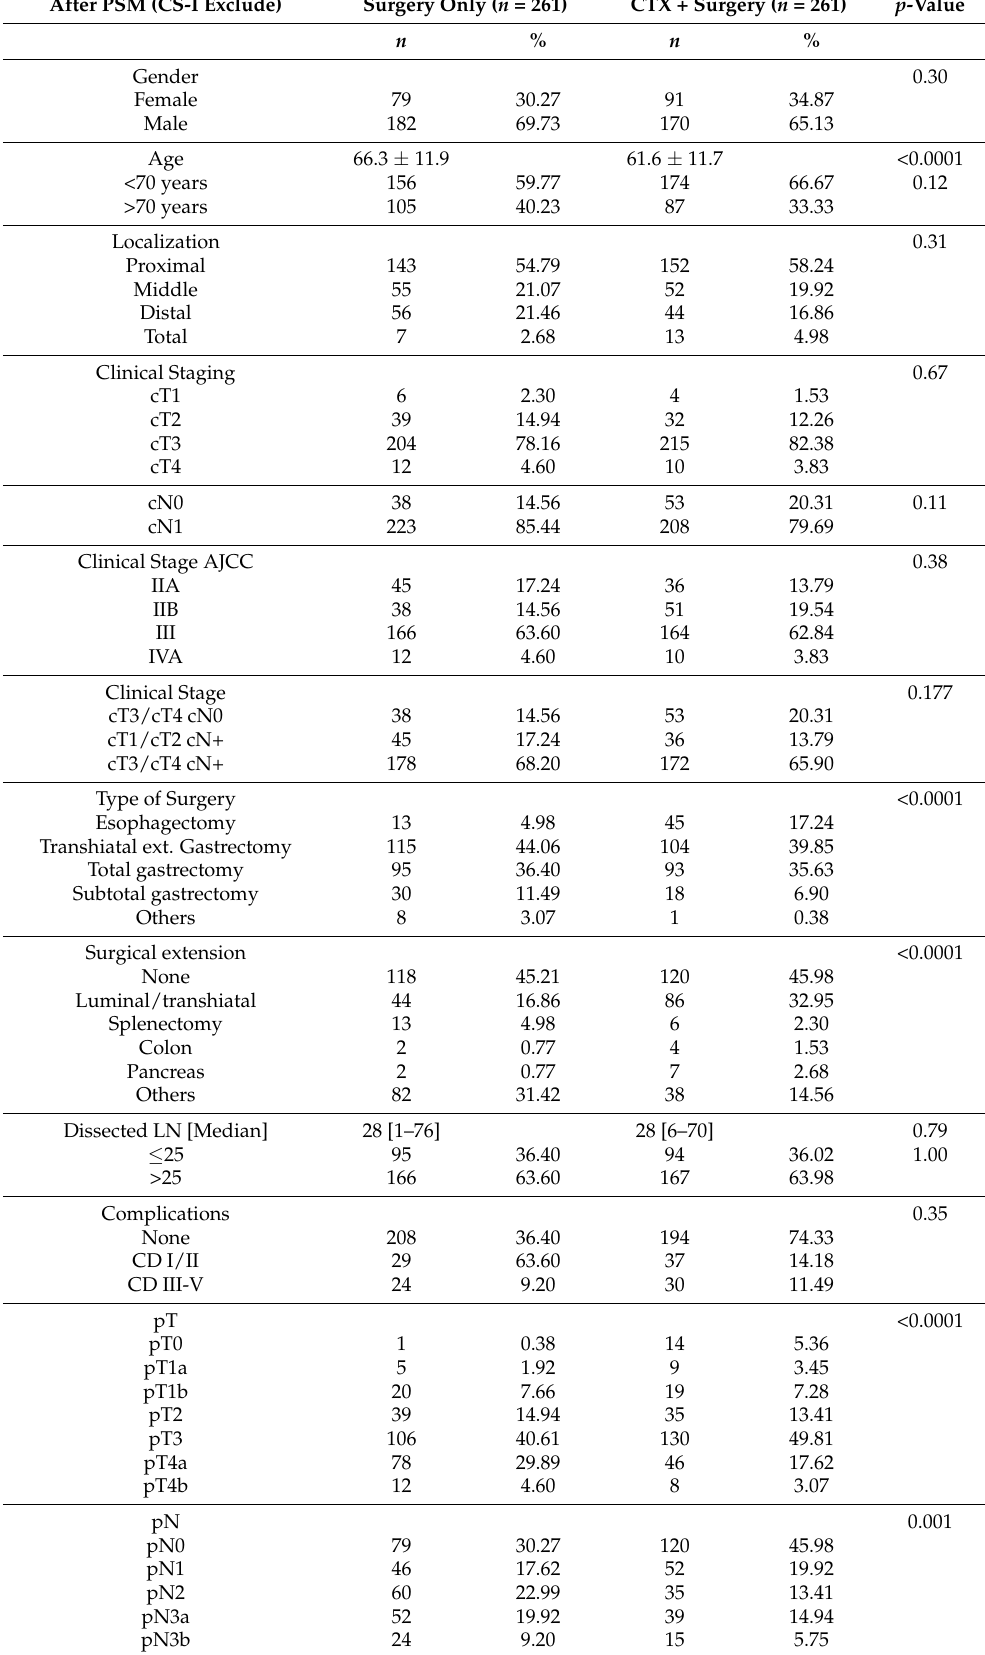
Table 4. Baselines after